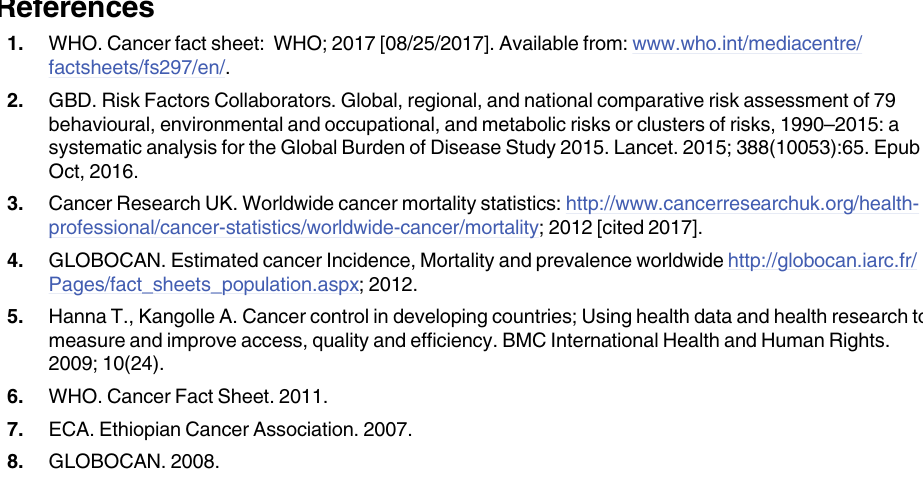
S1 Table. Fully adjusted effects of selected socio-demographic and clinical characteristics on the odds of being